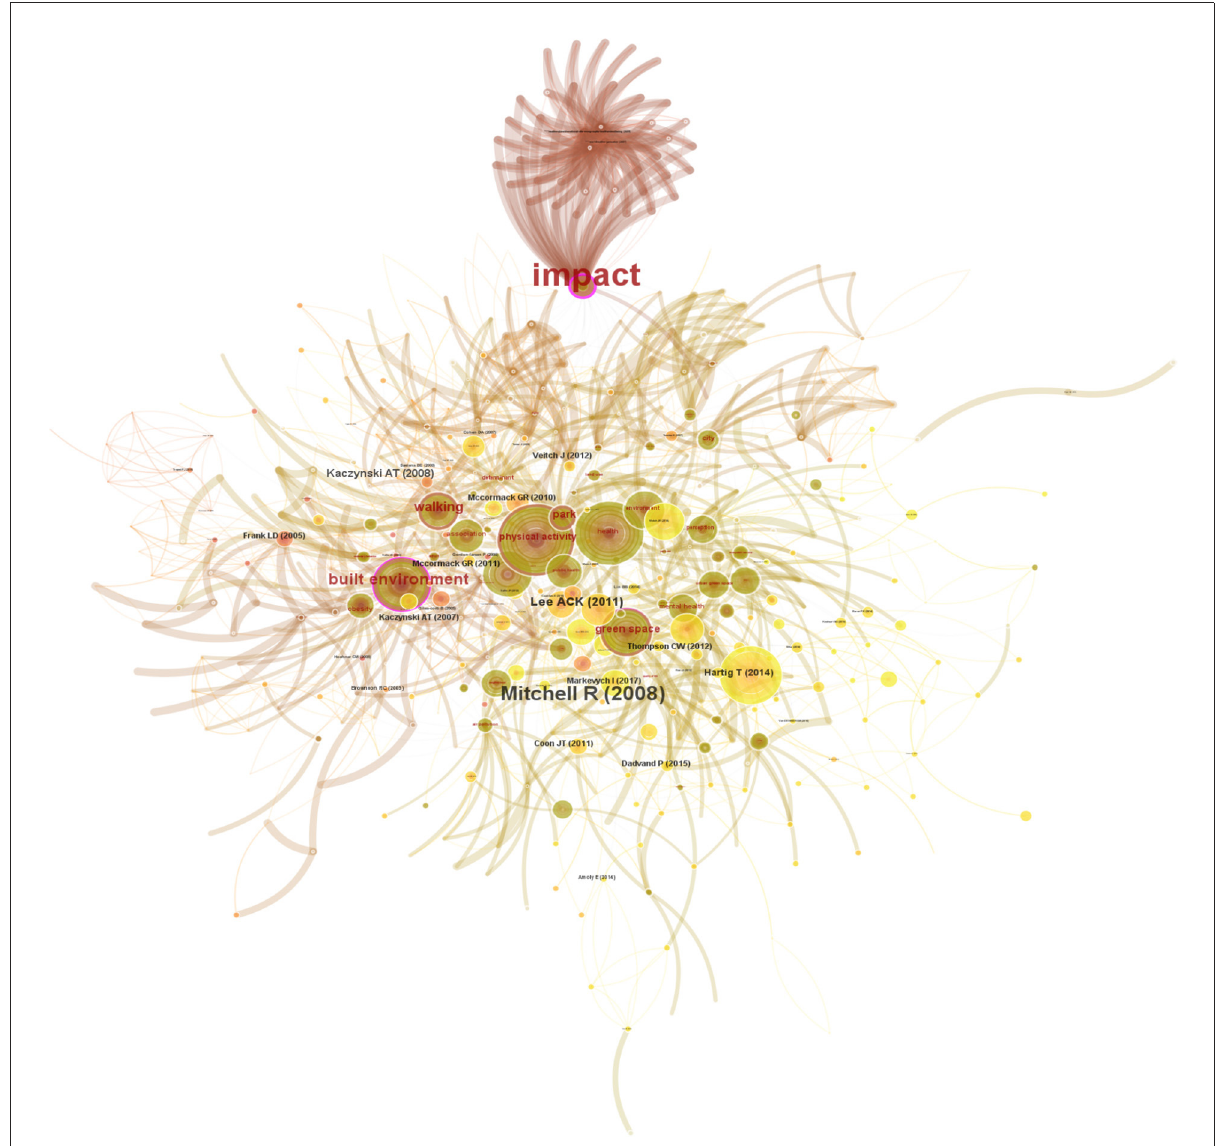
FIGURE7 Map of burst detection of emerging terms and